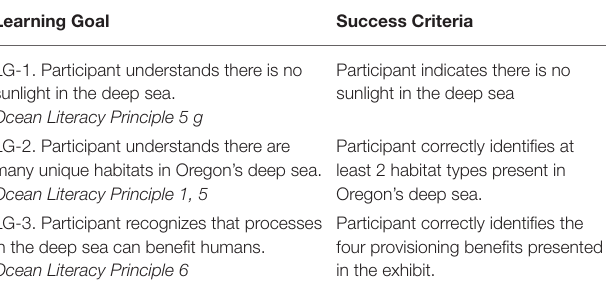
TABLE 1 | Exhibit Learning Goals (LG) and Success